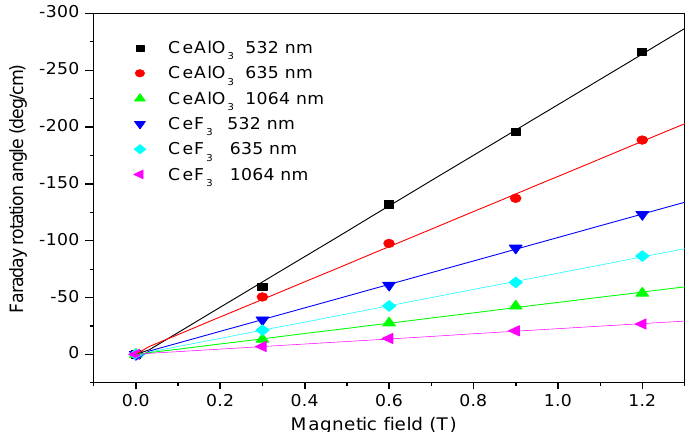
Figure 8. Relationships between the Faraday rotation and magnetic field of CeAlO 3 and CeF 3 crystals at different wavelengths.